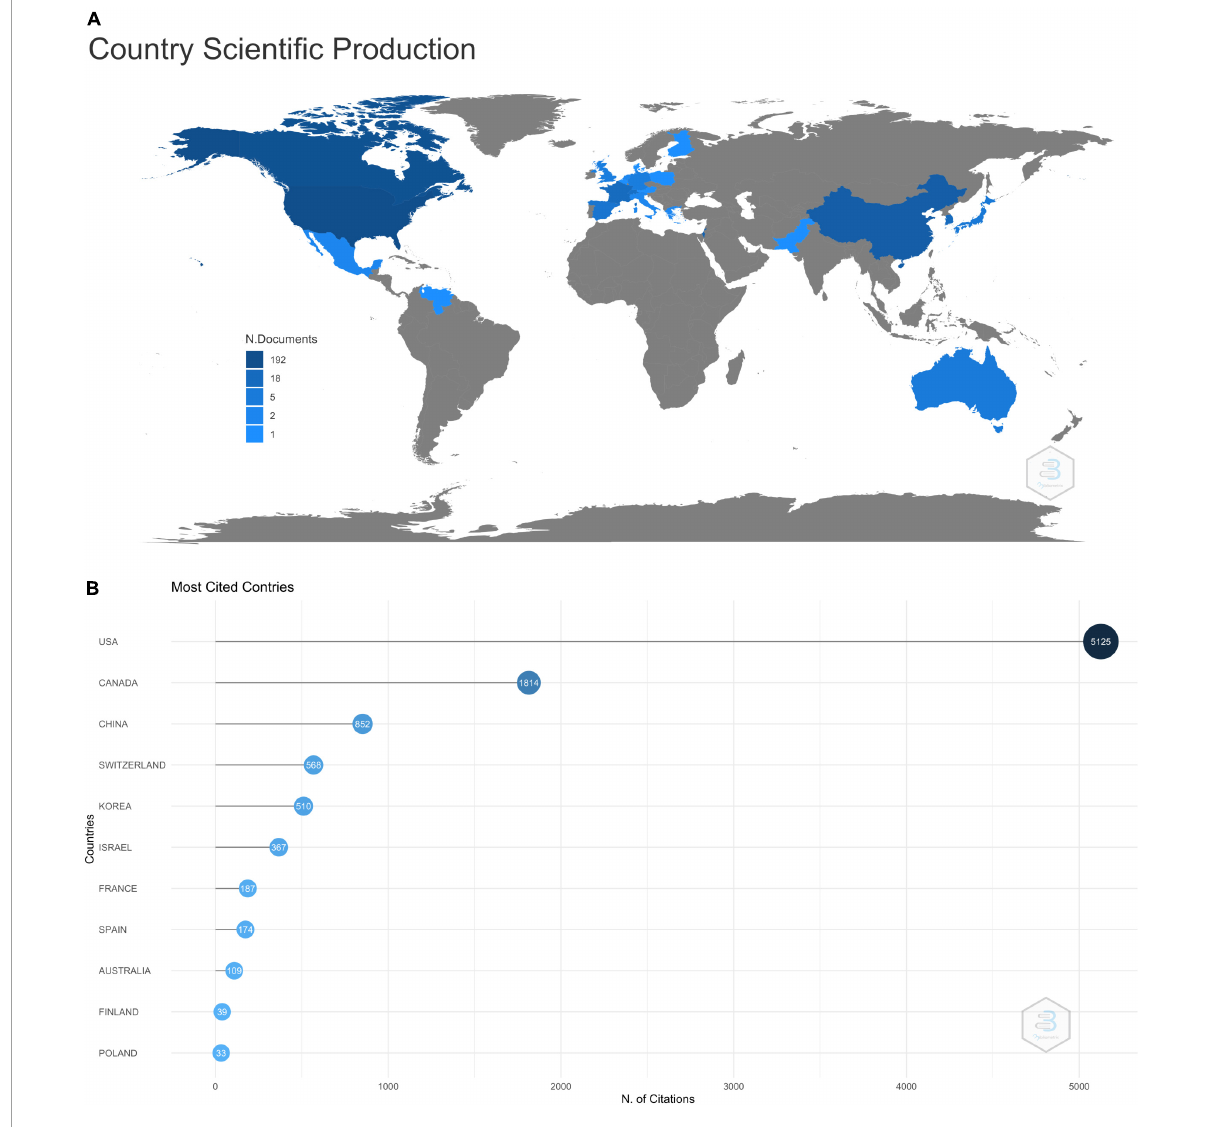
FIGURE5 (A) Shade graded world map showing the distribution of scientific publications per the total number of authors from a country with the darker shade implying a greater number of authors from a country. (B) Graph showing the number of citations received by the articles published from various countries (as per the country of the corresponding